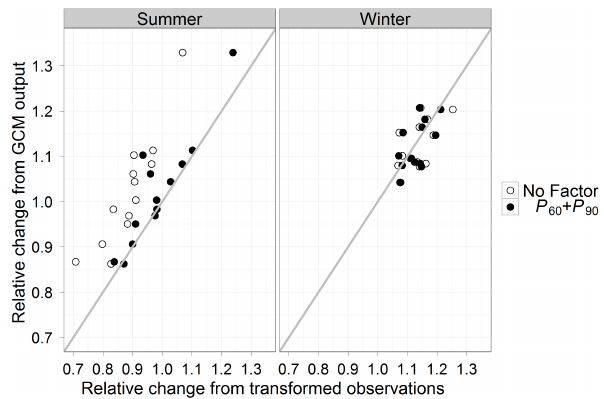
Fig. 4. Comparison of the relative change (future versus present day) of the mean 10-day maximum basin-average precipitation de- rived directly from the raw GCM model output versus the change obtained from the transformation procedure for summer (left panel) and winter (right panel). Relative changes from the transformed ob- servations are shown for no bias correction (No Factor) and for bias correction on P 60 and P 90 ( P 60 + P 90 ). The grey line represents op- timal correspondence (i.e. the 1:1